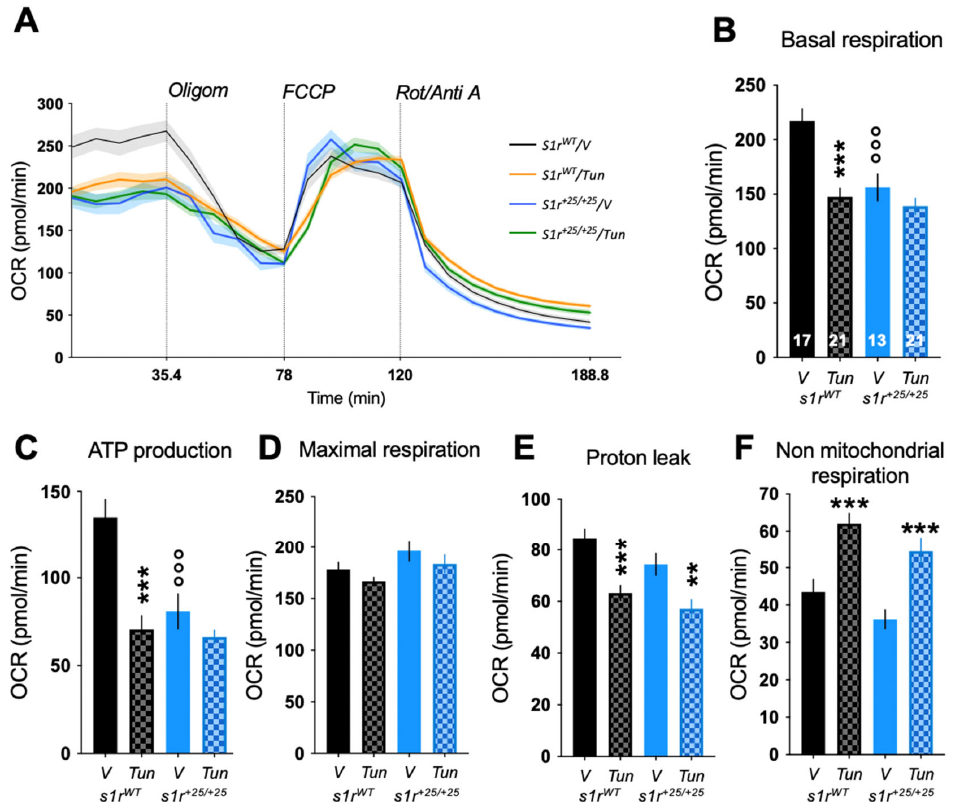
Figure 7. Effect of the Tunicamycin (Tun, 2 µ g/mL, 24 h) challenge on mitochondrial respiration of the zebrafish larvae at 5 dpf analyzed using the Seahorse XF mito stress test. ( A ) Profiles of oxygen consumption rate (OCR) during the assay. ( B ) Basal respiration, ( C ) ATP production, ( D ) maximal respiration, ( E ) proton leak, ( F ) non ‐ mitochondrial respiration. Data are shown as mean ± SEM from the number of larvae indicated in ( B ). Abbreviations: Oligom, oligomycin (25 μ M); FCCP, carbonyl cyanide ‐ p ‐ trifluoromethoxyphenylhydrazone (8 μ M); Rot/Anti A, rotenone + antimycin A (15 μ M). ** p < 0.01, *** p < 0.001 vs. V ‐ treated; °°° p < 0.001 vs. s1r WT ; Newman ‐ Keuls’ test after a two ‐ way ANOVA.